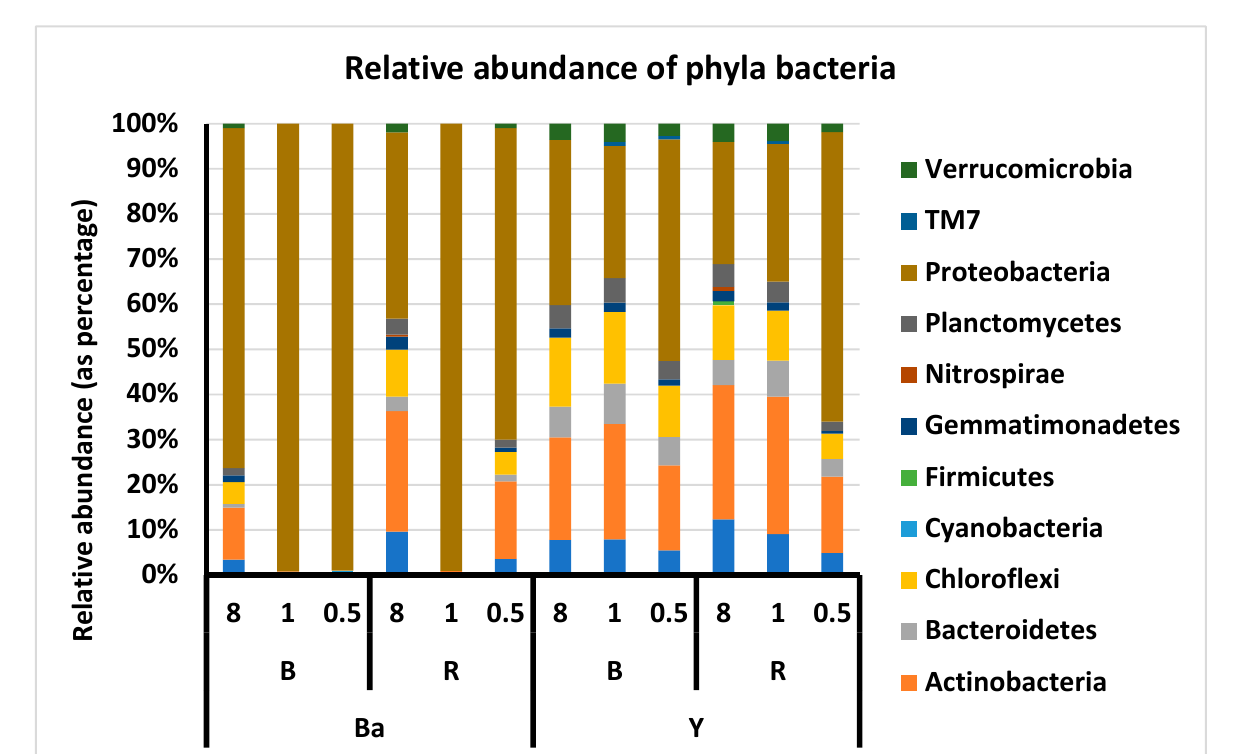
Figure 2. Relative abundance of bacterial phyla at different agro-management: organic (Y) and